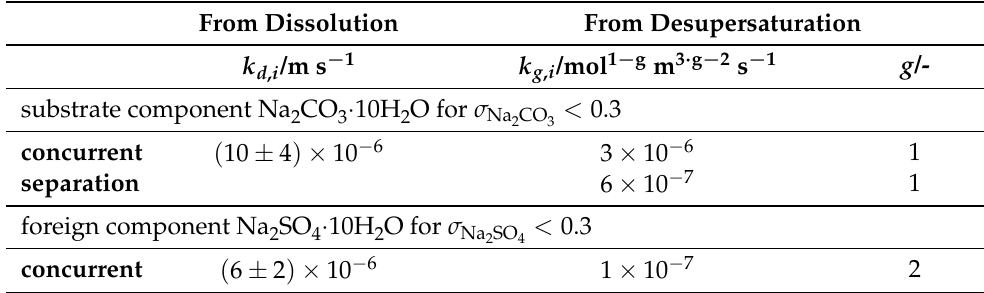
Table 3. List of ternary kinetic coefficients k g , i and crystallization orders g averaged over the tem- perature range of 17–23.5 °C on a sodium carbonate decahydrate substrate. The kinetics for both concurrent crystallization (Figure 10a) and material separation (Figure 10c) are shown. Mass transfer coefficients k d , i were estimated from dissolution measurements.